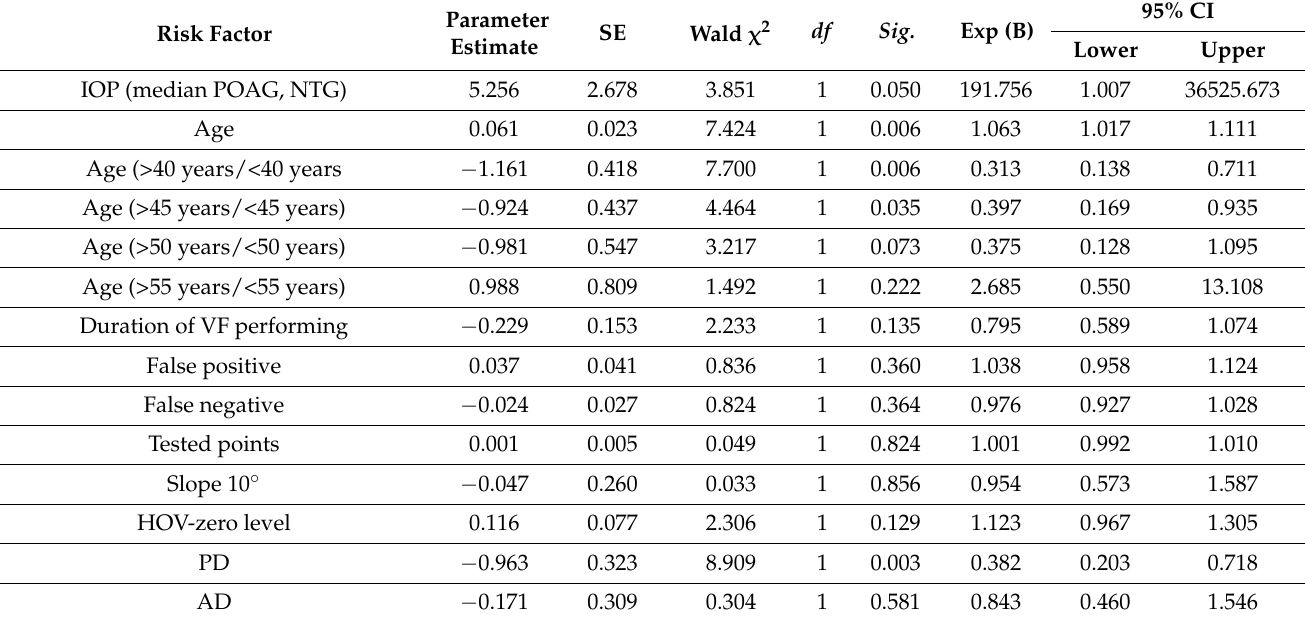
Table 10. Distribution of binomial logistic analysis results for POAG and NTG patients at the first